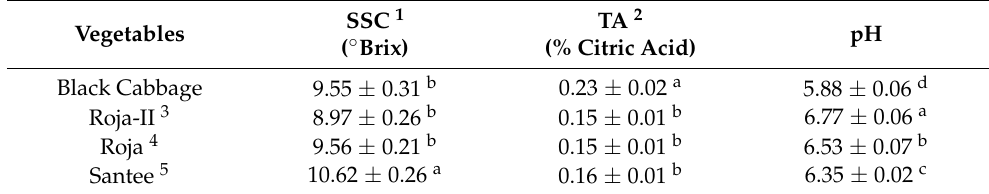
Table 2. Average values of total soluble solids content, titratable acidity, and pH of Brassica samples.